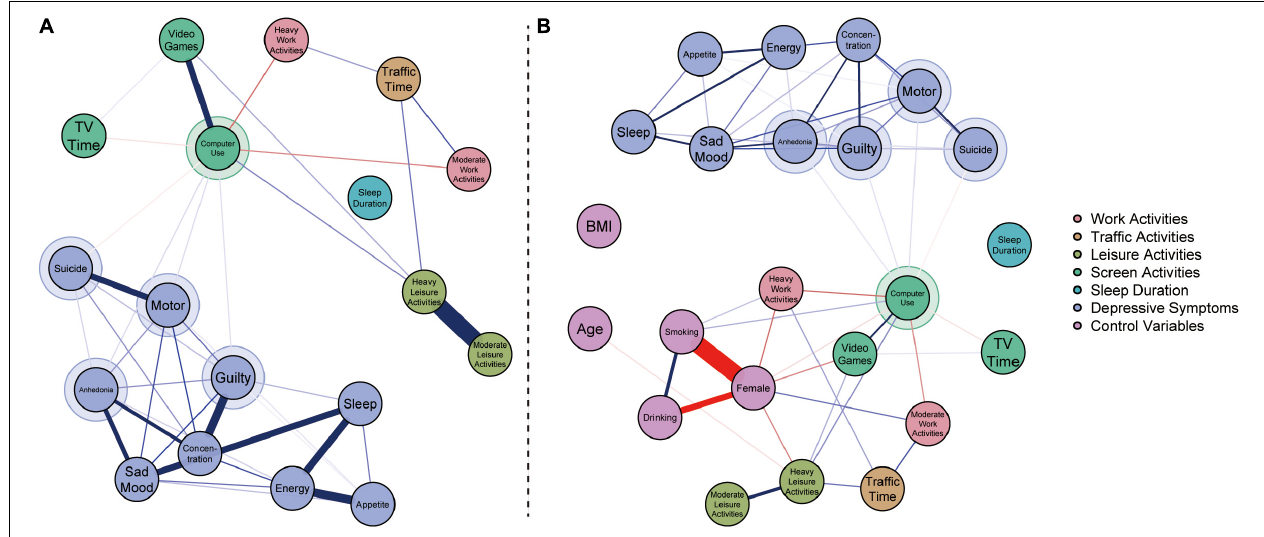
FIGURE 1 | Results of kestimated network models. The blue edges denote the positive relationships, and the red edges denote the negative relationships. The direct linked nodes among time use behaviors and depressive symptoms were highlighted with larger circles. (A) Results of the estimated network without control variables. (B) Results of the estimated network with control variables.